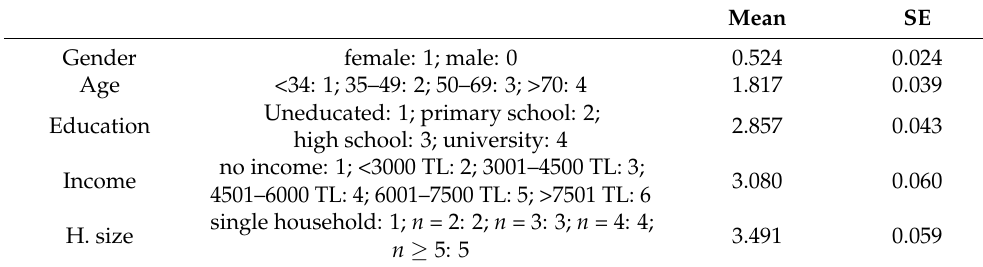
Table 3. Categorization and mean values of the socio-demographic